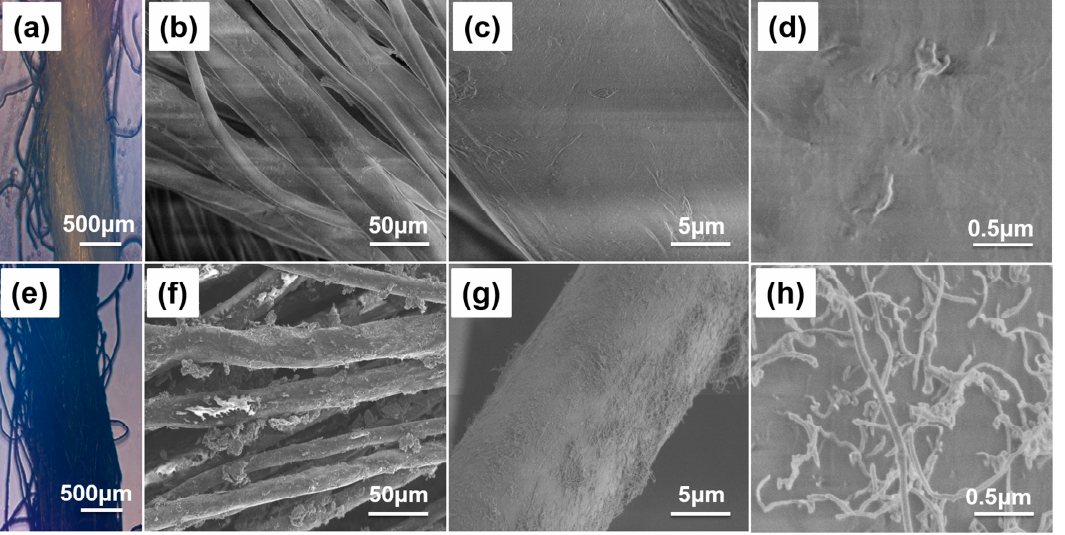
Figure 3. Microscope and SEM images of the hierarchical structure and surface morphology of cotton yarns before and after SWNT coating. ( a , e ) are optical images of two-strand twisted pristine cotton yarn and SWNT-coating cotton yarn; ( b – d ) SEM images of the hierarchical structure and morphology of pristine cotton yarn (no coating); ( f – h ) SEM images of the hierarchical structure and morphology of SWNT-coated cotton microfibrils.